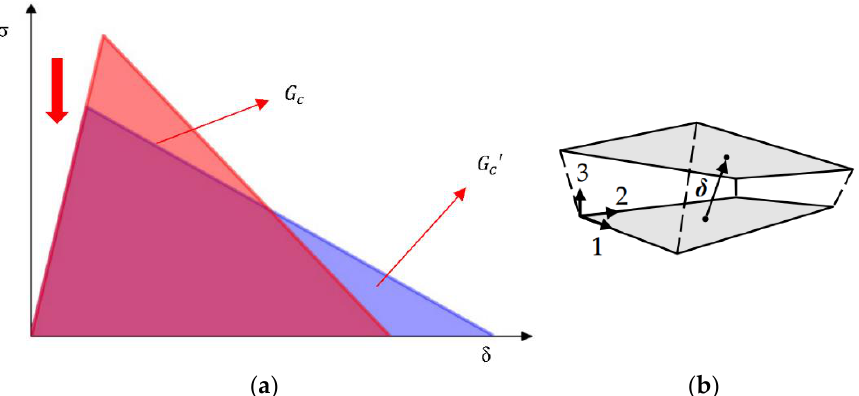
Figure 2. Relationship between energy release rate and interlaminar strength. ( a ) Energy release rate of the same area; ( b ) Parameters of the SURFACE_TO_SURFACE_TIEBREAK contact with OPTION 9.